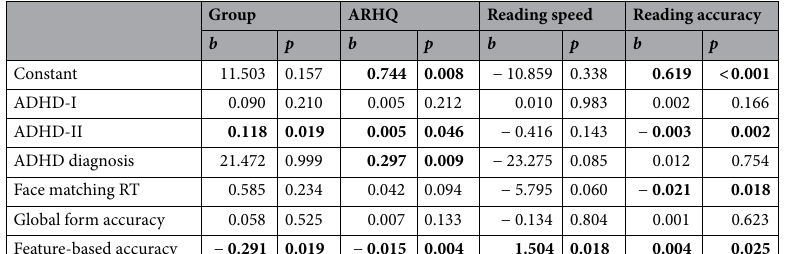
2 (6) = 32.085, p < 0.001,